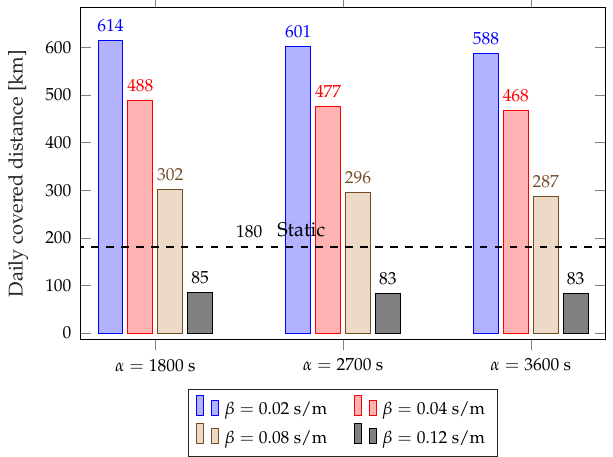
Figure 9. Average daily distance covered by rebalancing trucks for different values of α and β .